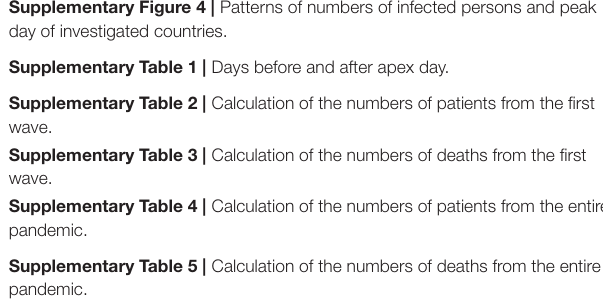
Supplementary Figure 2 | Relationship between number of infected persons before the apex day and the total number.